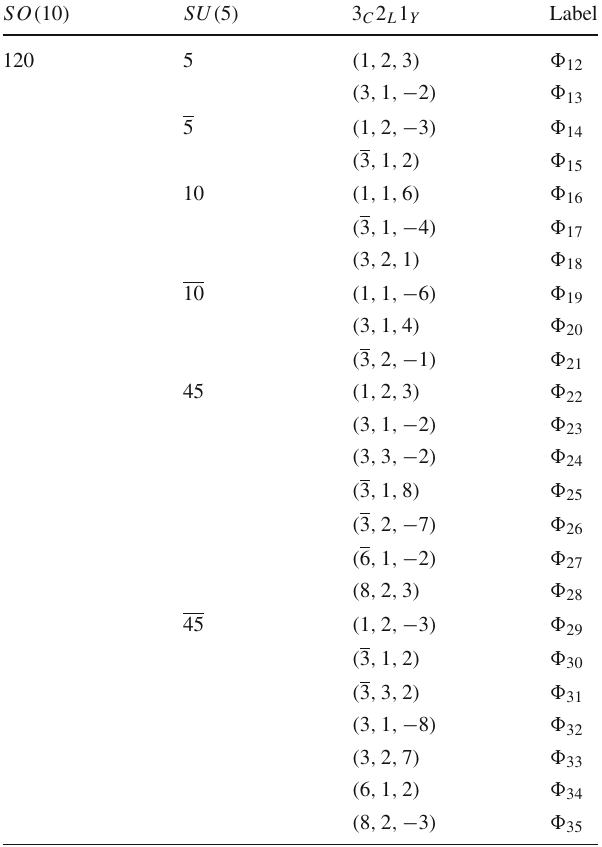
Table 4 Decomposition of the scalar 120 representation of SO ( 10 ) with respect to the subgroups SU ( 5 ) and SU ( 3 ) C × SU ( 2 ) L × U ( 1 ) Y . For further details, see Table 1